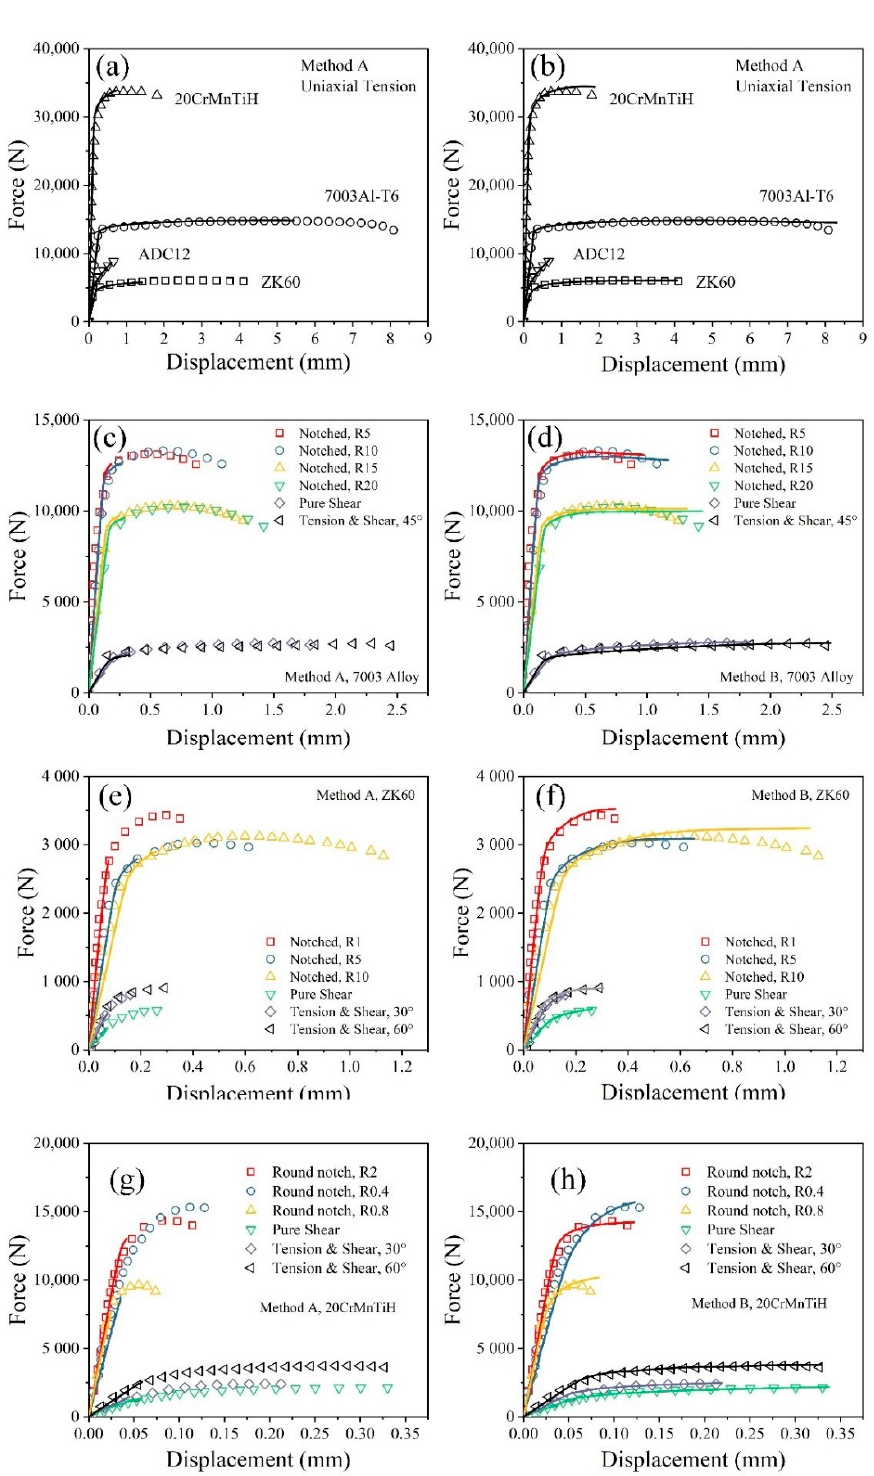
Figure 11. Force and displacement curves for ( a ) uniaxial tensile tests based on method A, ( b ) uniaxial tensile tests based on method B, ( c ) 7003Al alloy based on method A, ( d ) 7003Al alloy based on method B, ( e ) ZK60 Mg alloy based on method A, ( f ) ZK60 Mg alloy based on method B, ( g ) 20CrMnTiH based on method A and ( h ) 20CrMnTiH based on method B.